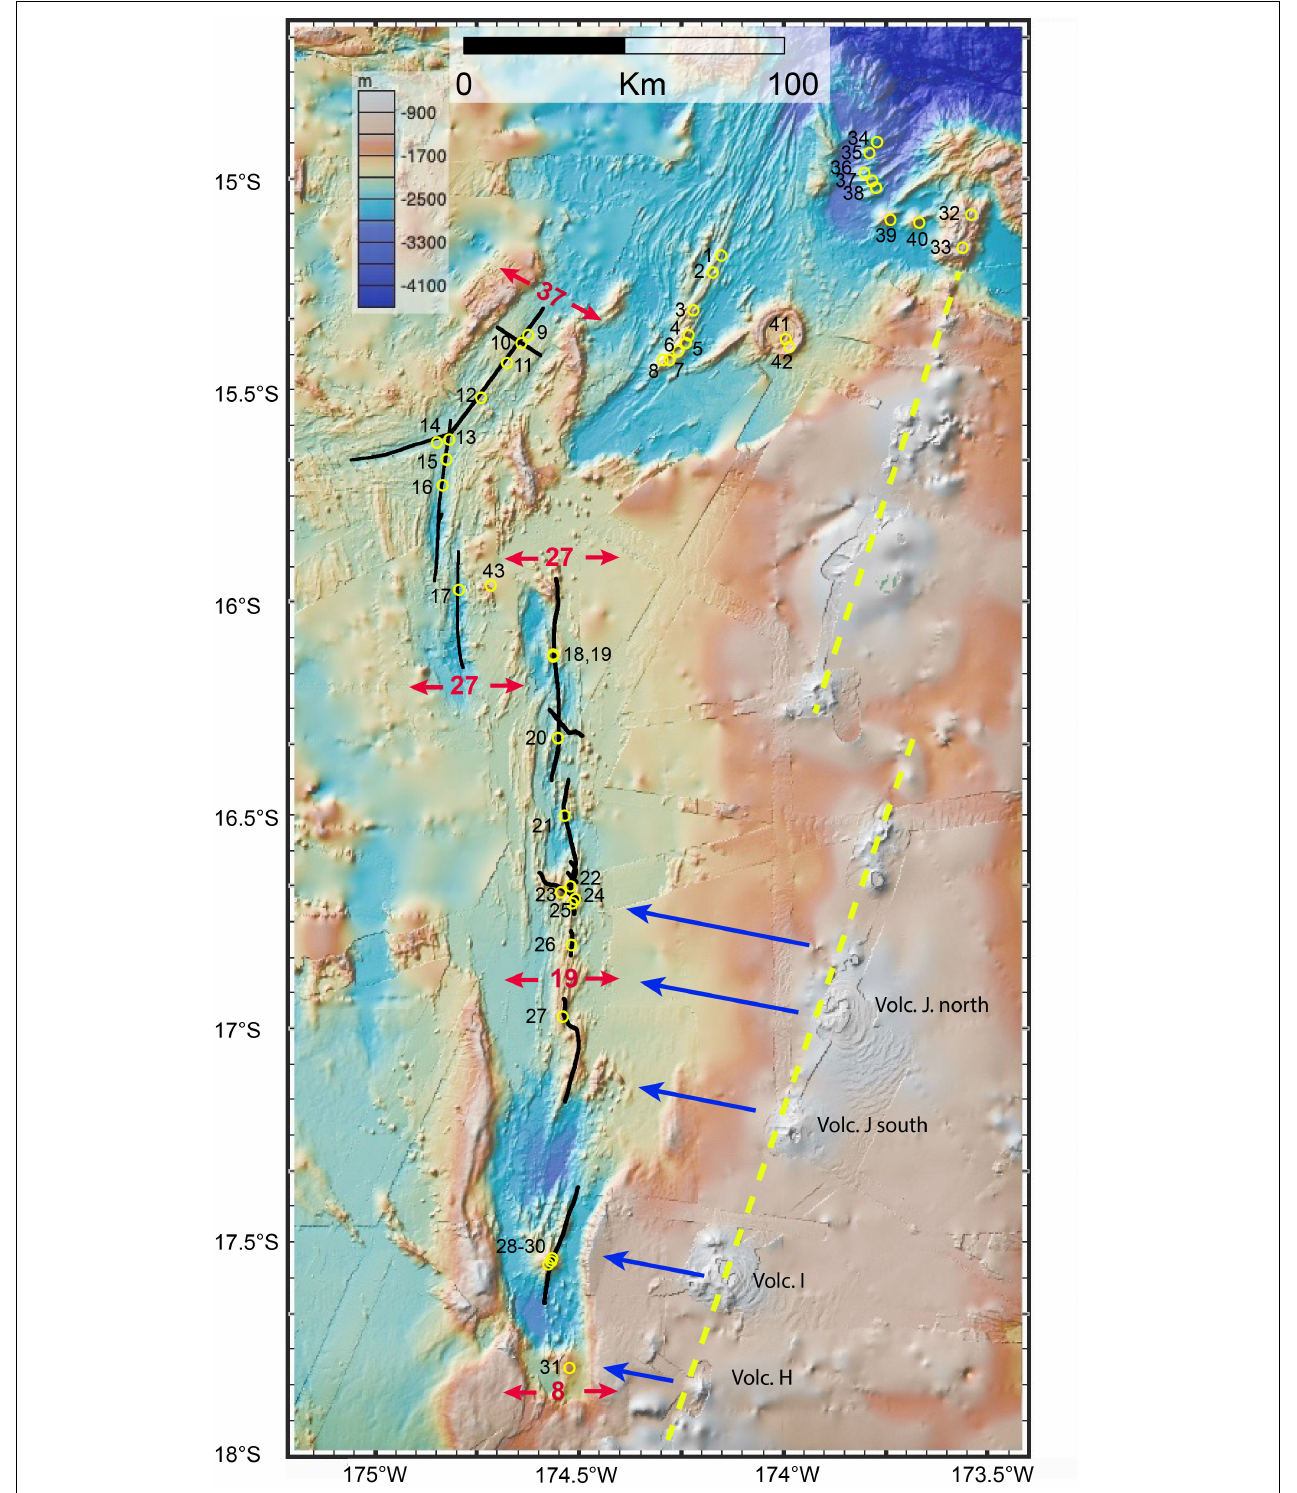
FIGURE 3 | Survey tow lines (black) and active hydrothermal sites (yellow circles) of the MTJ and the FRSC. Numbers correspond to sites in Table 1 . This figure also includes all the known active sites in the NE Lau Basin ( Tables 1 , 2 ). Red arrows indicate full rate spreading values (mm/year). Tofua arc strike follows the dashed yellow line. Blue arrows, aligned in the direction of the Pacific slab flow line, indicate correspondence between arc and FRSC volcanoes within 70 km of the Tofua arc (Sleeper et al., 2016). Figure made with GeoMapApp (www.geomapapp.org).